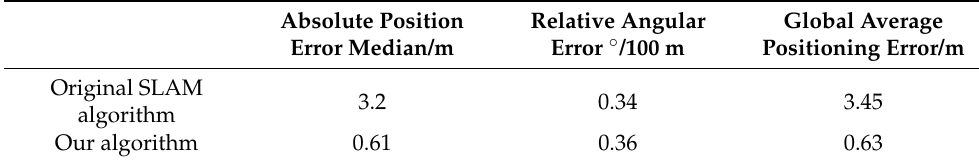
Figure 13. Experiments results in closed loop path. Table 3. Error comparison.